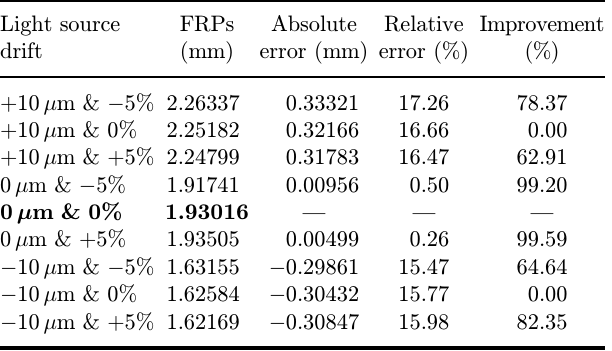
Table 11. Comprehensive errors of positioning inaccuracy and light source drift with NP.